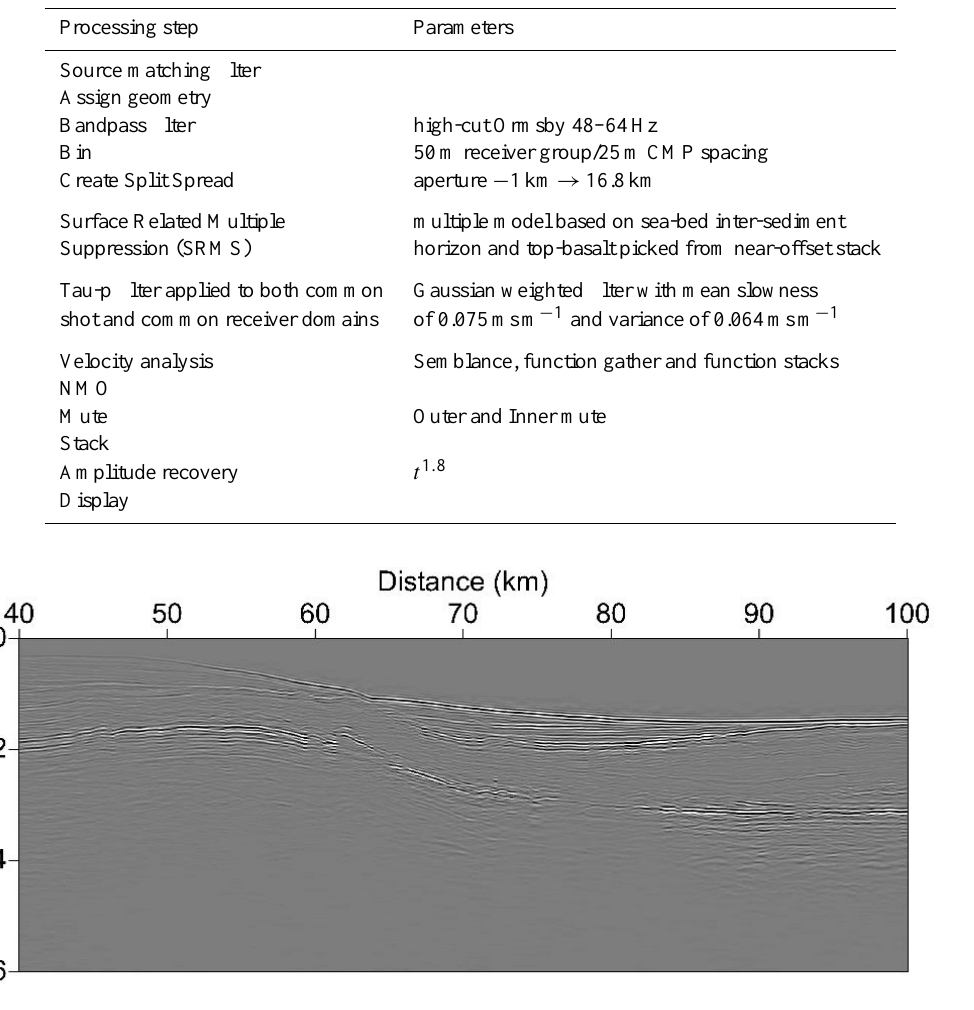
Table 1. Processing steps applied to data.